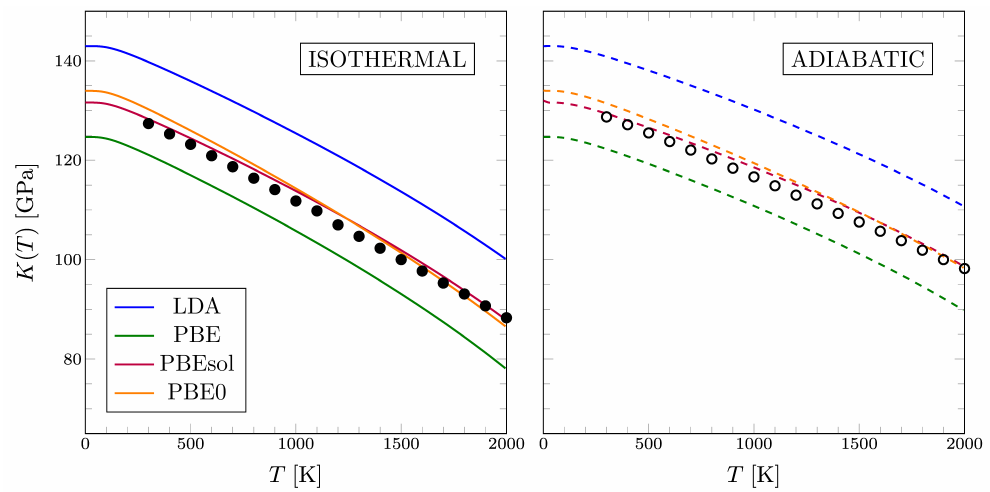
Figure 2. Thermal dependence of the isothermal K T (left panel) and adiabatic K S (right panel) bulk modulus of forsterite up to 2000 K. Experimental data (filled and empty black circles) are from Anderson et al. [58]. Lines correspond to quasi-harmonic computed values with different functionals of the DFT: LDA (blue), PBE (green), PBEsol (red), and PBE0